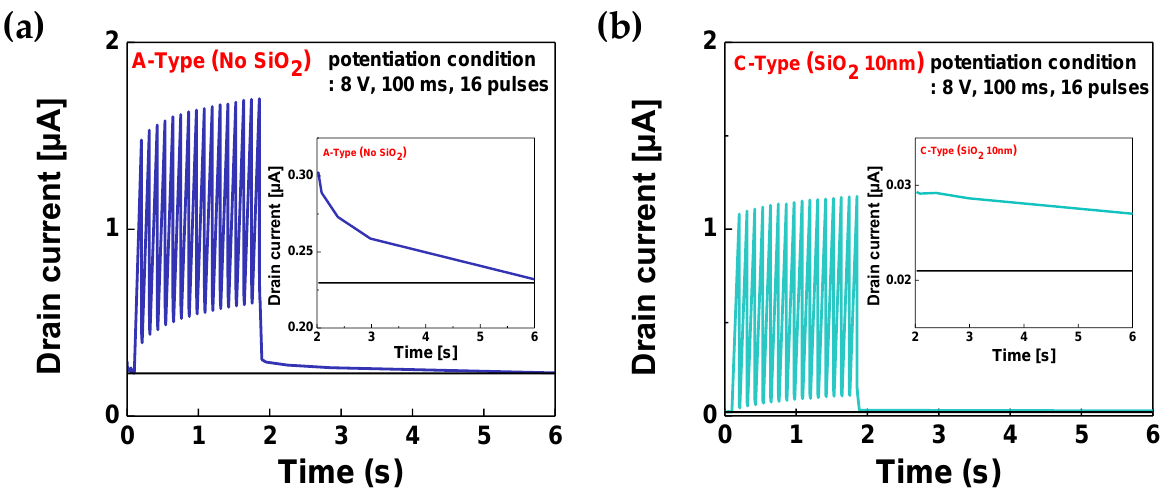
Figure 6. Retention characteristics of ( a ) A-type and ( b ) C-type devices after 16 potentiation pulses with V GS = 8 V and 100 ms width.